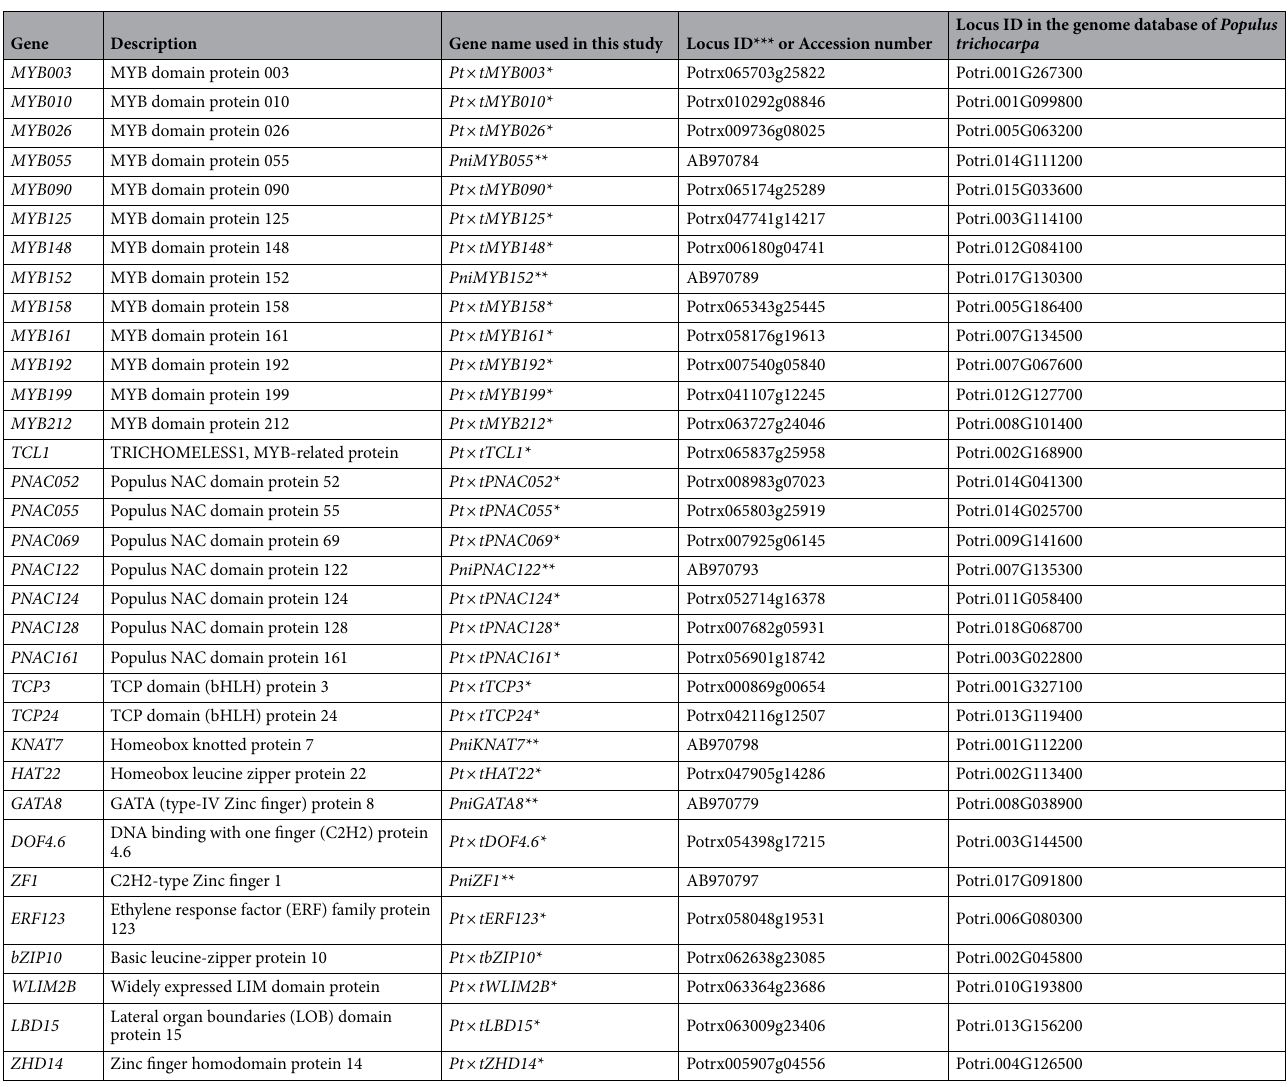
Table 1. List of transcription factors selected in this study. *Pt × t; Populus tremula × Populus tremuloides. **Pni; Populus nigra. *** http://popge